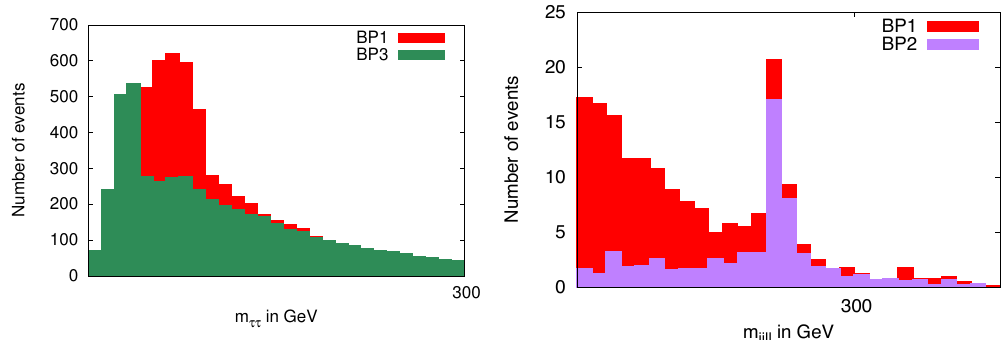
Figure 4 . (cid:28)(cid:28) invariant mass distribution (left panel) and jj‘‘ invariant mass distribution (right panel) for the benchmark points at an integrated luminosity of 100 fb (cid:0) 1 at the LHC with 14 TeV center of mass